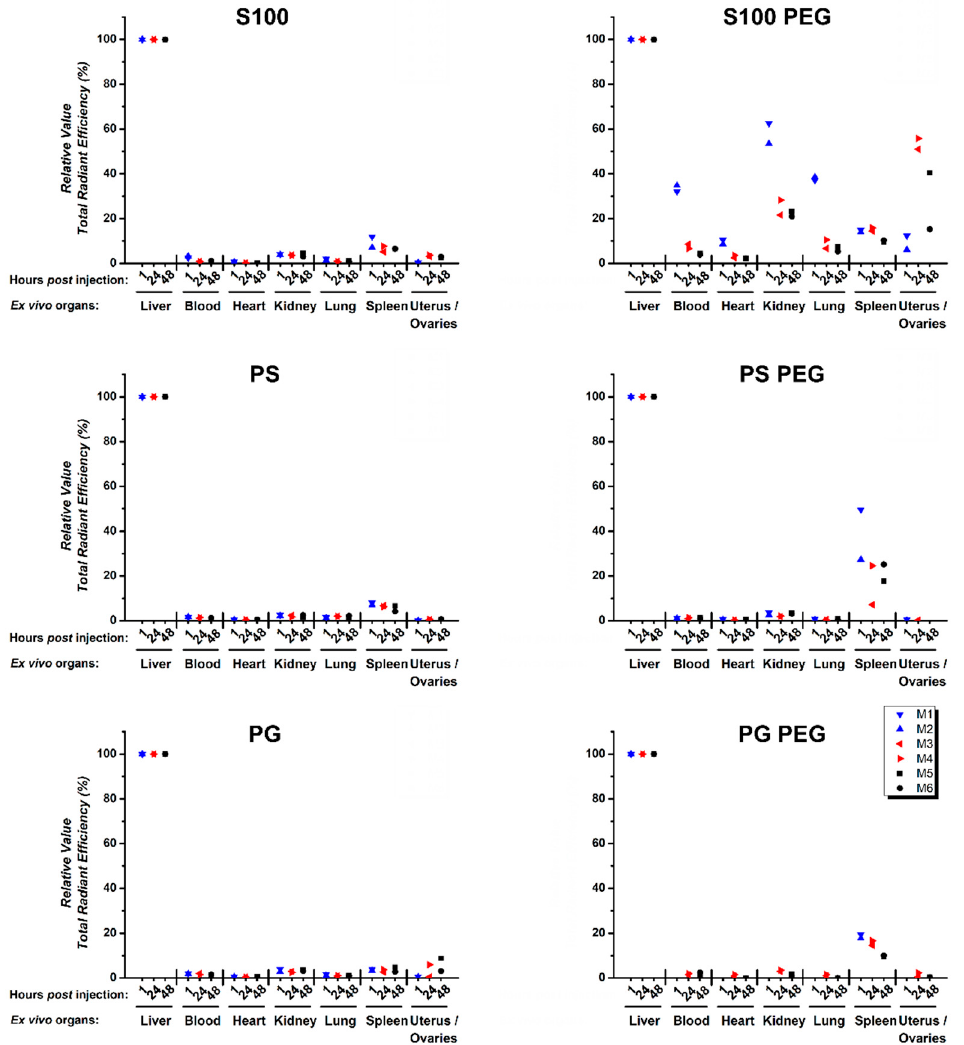
Figure 4. Quantification of ex vivo single organ total radiant efficiencies (TREs) (pre-selected) shows systemic and spatial accumulation of S100 PEG and fast clearance of other formulations via liver and spleen. Signals were evaluated from defined ROI in DiR-loaded liposome-treated excised single organs, as assessed by ex vivo FI. M1 to M6 represent individual female mouse values. M1 and M2 were sacrificed at t = 1 h, M3 and M4 at t = 24 h and M5 and M6 at t = 48 h. Presented values are relative to the TRE of the respective liver.